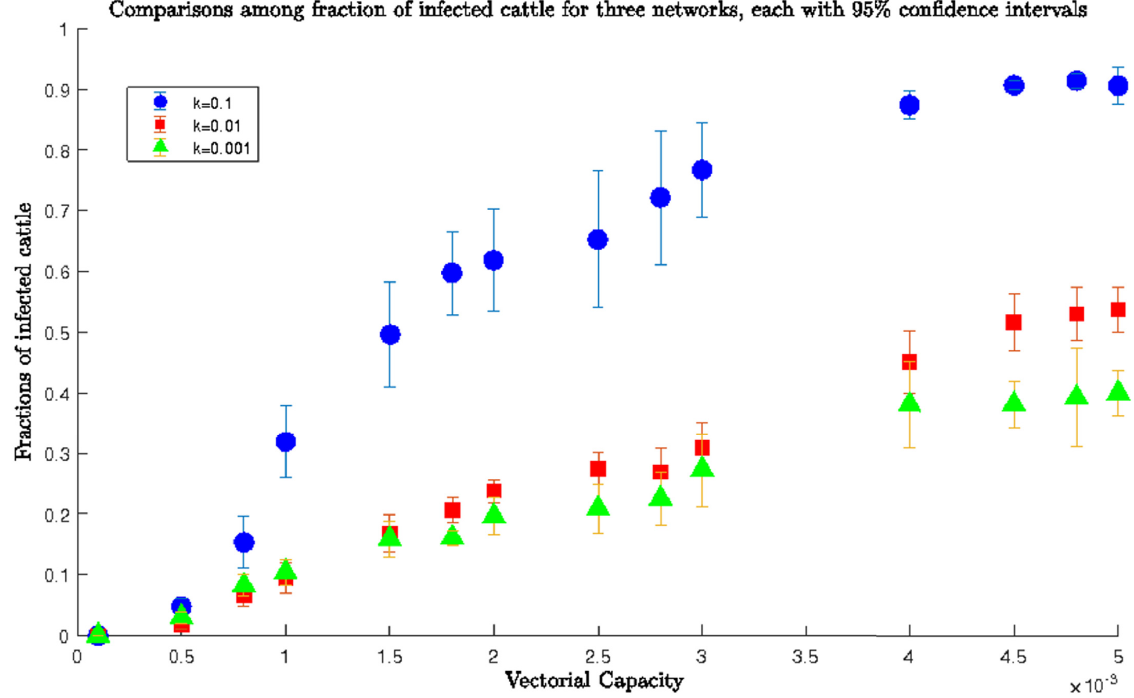
Fig 4. Comparisons among fractions of infected cattle for a homogeneous network for three different values of k and lower range of β ; blue dots showed the fraction of infected for k = 0.1, while red rectangles and green triangles showed the fraction of infected for k = 0.01 and 0.001 respectively. For the same value of transmission rate, we always had more infected cattle for greater values of k (0.1) than the smaller ones (0.01 and 0.001). Therefore, increasing movement probability meant more widespread epizootic. For example, the fraction of infected cattle at β = 0,005 was ~0.399, ~0.537, and ~1 for k = 0.001, 0.01, and 0.1,